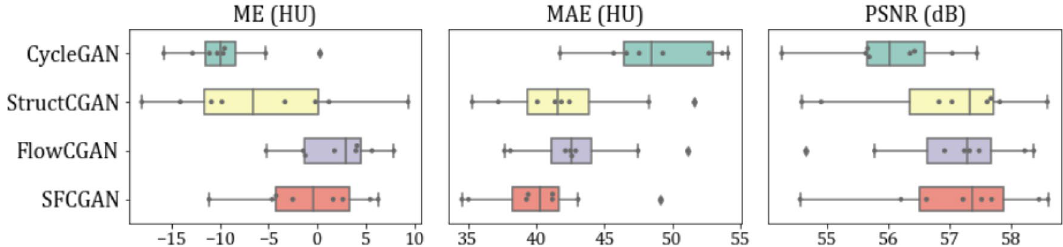
Figure 3. Box plots illustrating the Mean Error (ME), Mean Absolute Error (MAE) and PSNR scores distribution across test dataset volumes for CycleGAN, StructGAN, FlowCGAN and SFCGAN